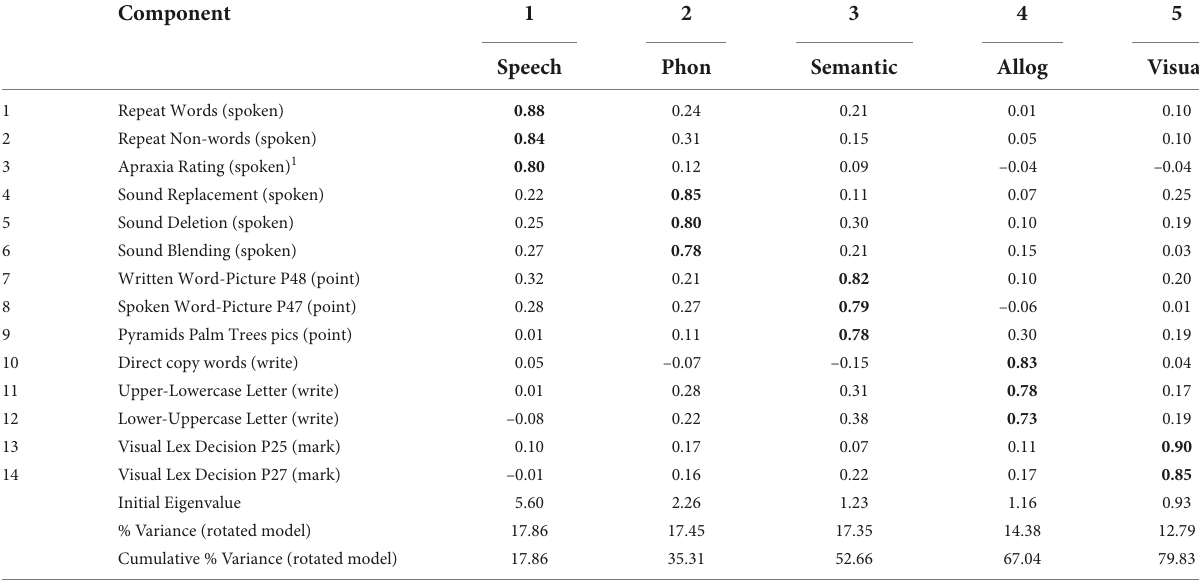
TABLE 6 Results from optimal principal components analysis implemented using 14 scores from 87 language impaired individuals.